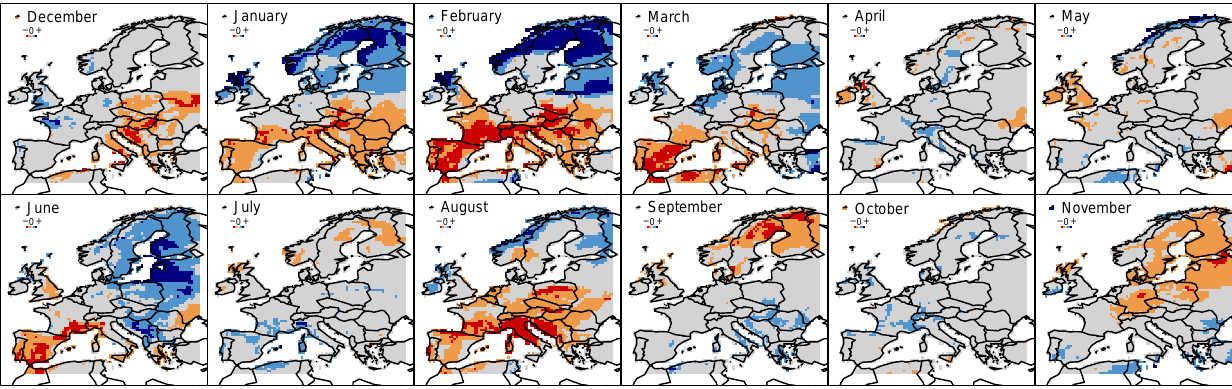
Figure 3. Monthly frequency trends in wet STs significant at the 70% (light colours) and 95% (dark colours); increasing trends in blue, decreasing trends in